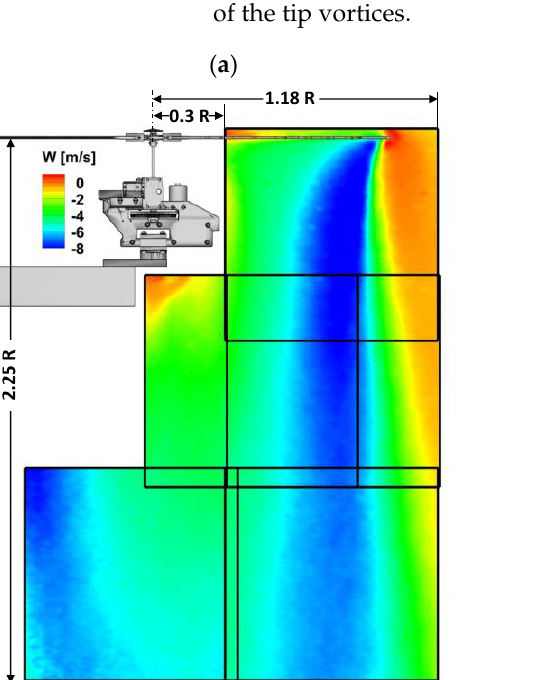
Figure 3. PIV measurement regions: ( a ) Rotor wake measurements, ( b ) Tip vortex characterization. To track the blade tip vortices in proximity to the rotor disk, the camera was equipped The results presented a velocity spatial resolution of ∆𝑥 = 0.47 mm . The random with a lens featuring a fixed focal length of f = 200 mm, and the f-number was set to noise of the PIV cross-correlation procedure can be estimated as 0.1 px as a rule–of–thumb f # = 2.8. The measurement region was located immediately below the rotor disk plane (Raffel et al. [26]). Using the current values for the optical resolution (17 px/mm) and the on a vertical plane radially ranging between x/R = 0.68 and x/R = 1.08 to identify the laser double–pulse delay (25 μs), this leads to a velocity error of ∆𝑉 of ≈ 0.23 m/s for the trajectories of the trailing tip vortices. Five PIV measurement regions with the size of PIV measurements. In the proximity to the rotor disk, the core radius r c of the tip vortices about 120 mm by 120 mm, partially overlapped, were used to measure the rotor wake, was measured. The core radius is defined as the distance from the vortex centre to the and in particular the blade tip vortices characteristics up to one radius downstream the rotor disc, Figure 3b. This yielded a spatial resolution of about 17 px/mm in the image plane. The delay time between the two laser pulses was set to 25 µ s according to the highest expected velocities in the flow. As tracer particles, sprayed diethylhexylsebacate (DEHS) oil was used. A seeding generator with 20 Laskin nozzles provided oil droplets with an average size less than 1 µ m. The full test room was seeded to have a homogenous concentration of particles. More than 150 image pairs were recorded at a frame rate of 3 Hz for each region of interest (ROI) over about 1450 rotor revolutions. The PIV images were pre-processed by applying a background grey-level subtraction. PIV-View 3.60 was used to process the images. The analysis consisted in a Multi-grid scheme with a B-Spline of 3rd order image deformation ending at 32 × 32 px 2 and 75% overlap. Correlation maps were calculated by FFT multiple correlations (Hart [25]) of 2 windows and a 3-point Gaussian peak fit was used to obtain the